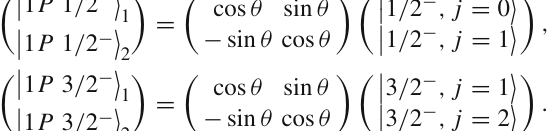
Fig. 2 The total decay widths versus the mixing angle θ . The red solid and blue dashed lines correspond to the | 1 P J P (cid:6) 1 and | 1 P J P (cid:6) 2 states, respectively, where the J P equals to 1 / 2 − or 3 / 2 − . The green bands are the experimental total decay